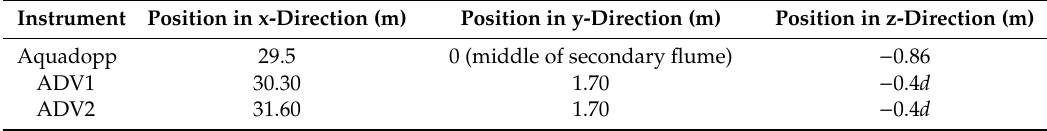
Table 3. Positions of the Aquadopp profiler and the two ADVs following the local reference system, as indicated in Figures 1 and 2.